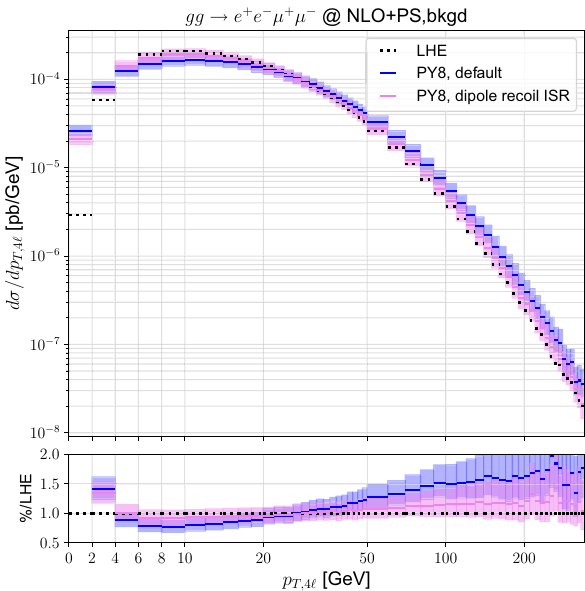
Fig. 11 Differential distribution in transverse momentum of the four charged leptons in gg → e + e − μ + μ − for the background contribution at the LHE level (black), and at the particle level, using the default PYTHIA 8 recoil (blue) and the fully local dipole recoil (violet). In the lower panel the ratio with respect to the LHE level is shown inthedipolescheme,thetransversemomentumrecoilforISR